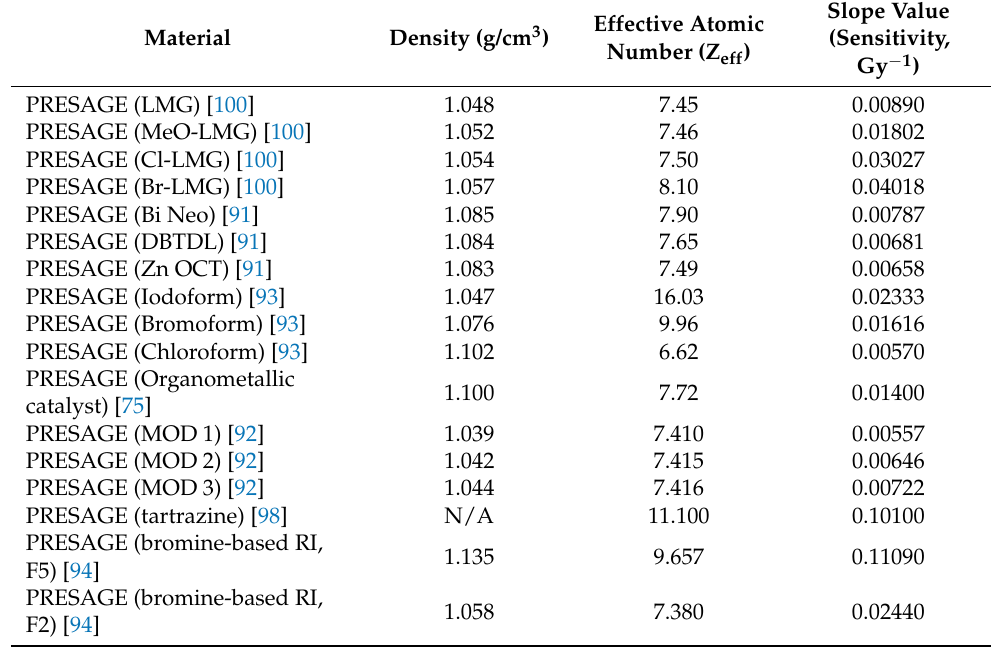
Table 2. The sensitivity of various PRESAGEs with their corresponding density and effective atomic